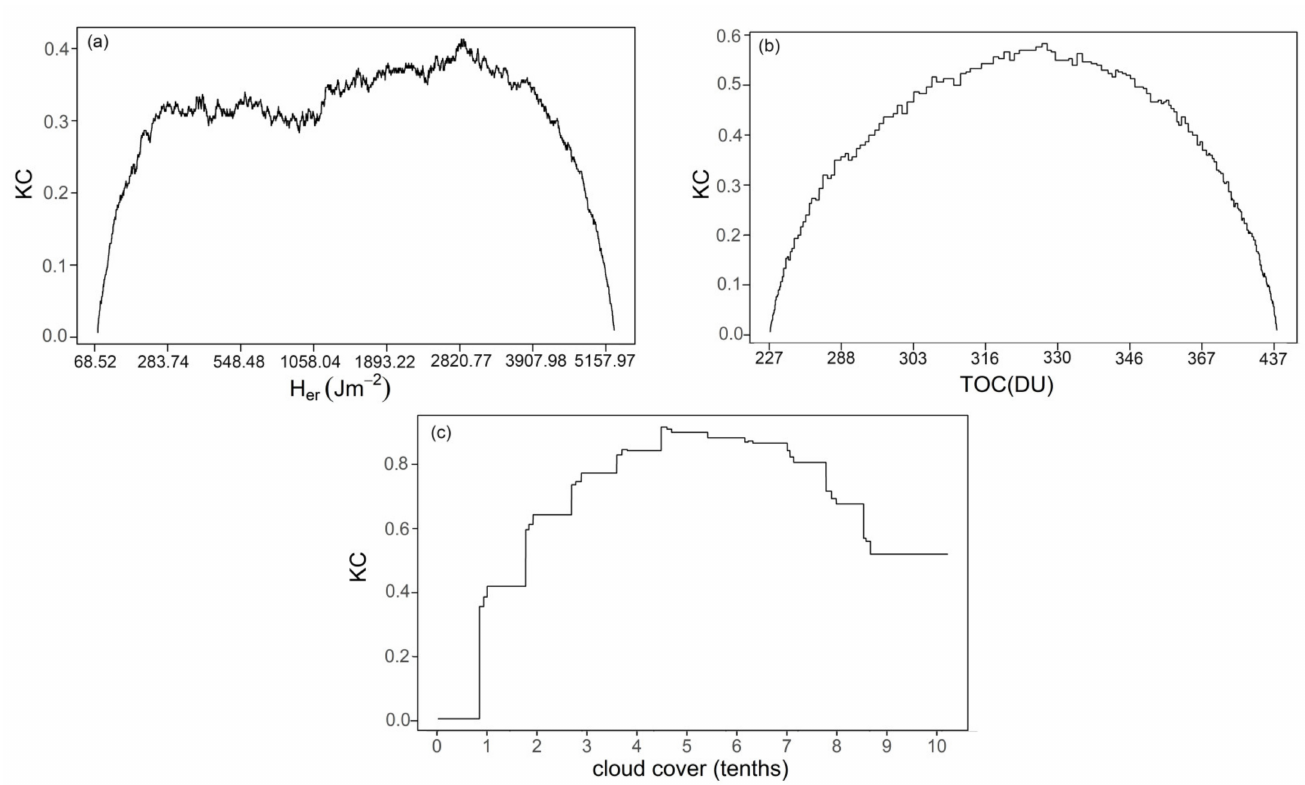
Figure 8. KC spectrum of ( a ) H er , ( b ) TOC, and ( c ) cloud cover spectrum sorted in ascending order of the observed variable of the daily H er time-series in Novi Sad.